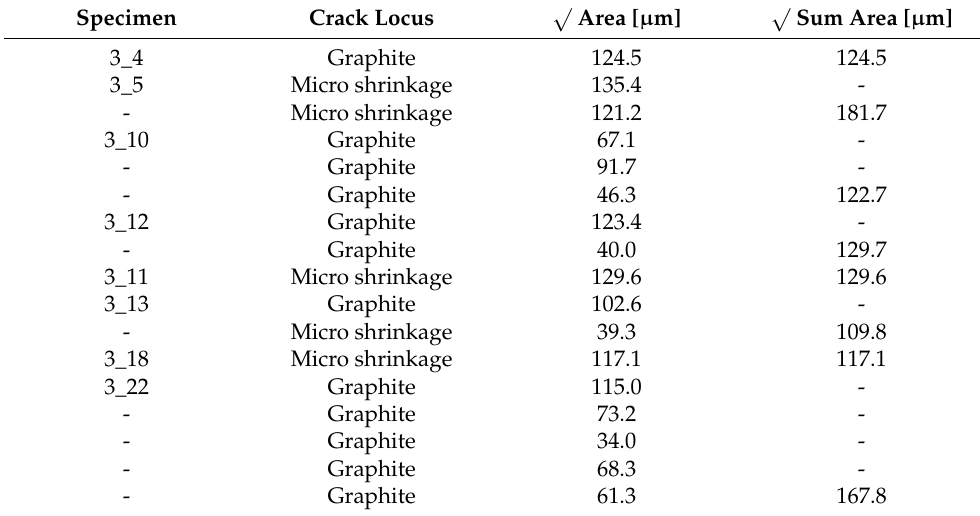
Table A3. Crack locus area sizes alloy 3.